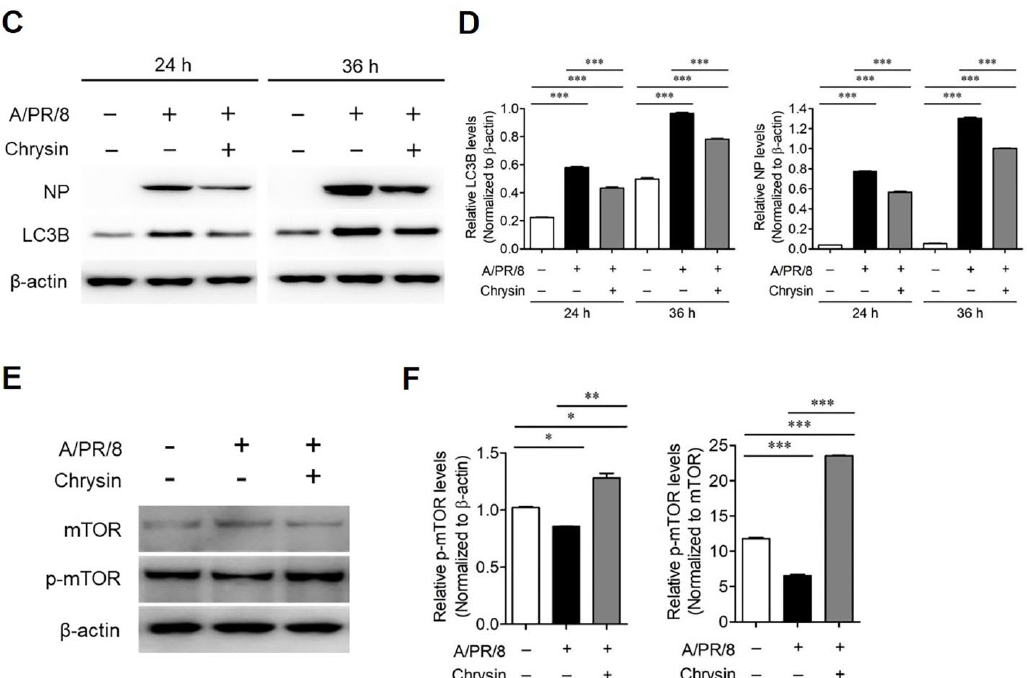
Figure 4. Autophagy was inhibited by chrysin in the A/PR/8-infected A549 cells. ( A ) The culture medium of A549 cells was pretreated with a control (DMSO) or 500 nM rapamycin for 1 h and was then treated with 50 µM chrysin. After 1 h, cell lysates were collected and subjected to Western blot analysis. ( B ) The ratios of LC3B to β -actin levels and p62 to β -actin levels based on the quantification of the bands in the immunoblot shown in ( A ). ( C ) Western blot analysis results of LC3B and NP in A/PR/8-infected and non-infected A549 cells after treatment with chrysin (50 µ M) for 24 and 36 h. ( D ) Expression levels of LC3B and NP normalized to that of β -actin are shown in the right panel. ( E ) Western blot analysis to detect mTOR and p-mTOR in A/PR/8-infected and non-infected A549 cells after 12 h of treatment with a vehicle or 50 µ M chrysin. ( F ) The ratios of p-mTOR to β -actin levels based on the quantification of the bands in the immunoblot shown in ( E ). Data are expressed as mean ± SD of the values obtained from three independent experiments. * p < 0.01, ** p < 0.001, and *** p < 0.0001 based on ANOVA with Bonferroni’s multiple comparison test.